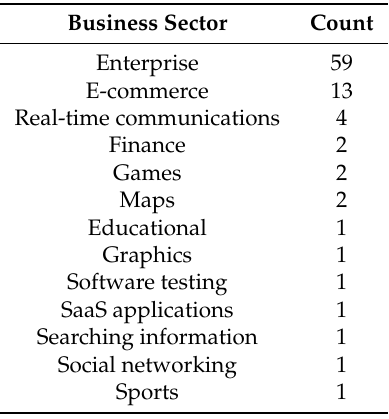
Table A8. 3.b. In which sector do you classify your system under test?